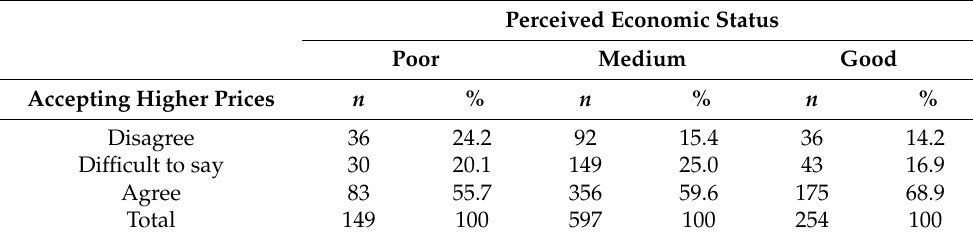
Table 3. Acceptance of higher prices for products that do not cause damage to the environment depending on the perceived economic status of the persons surveyed.